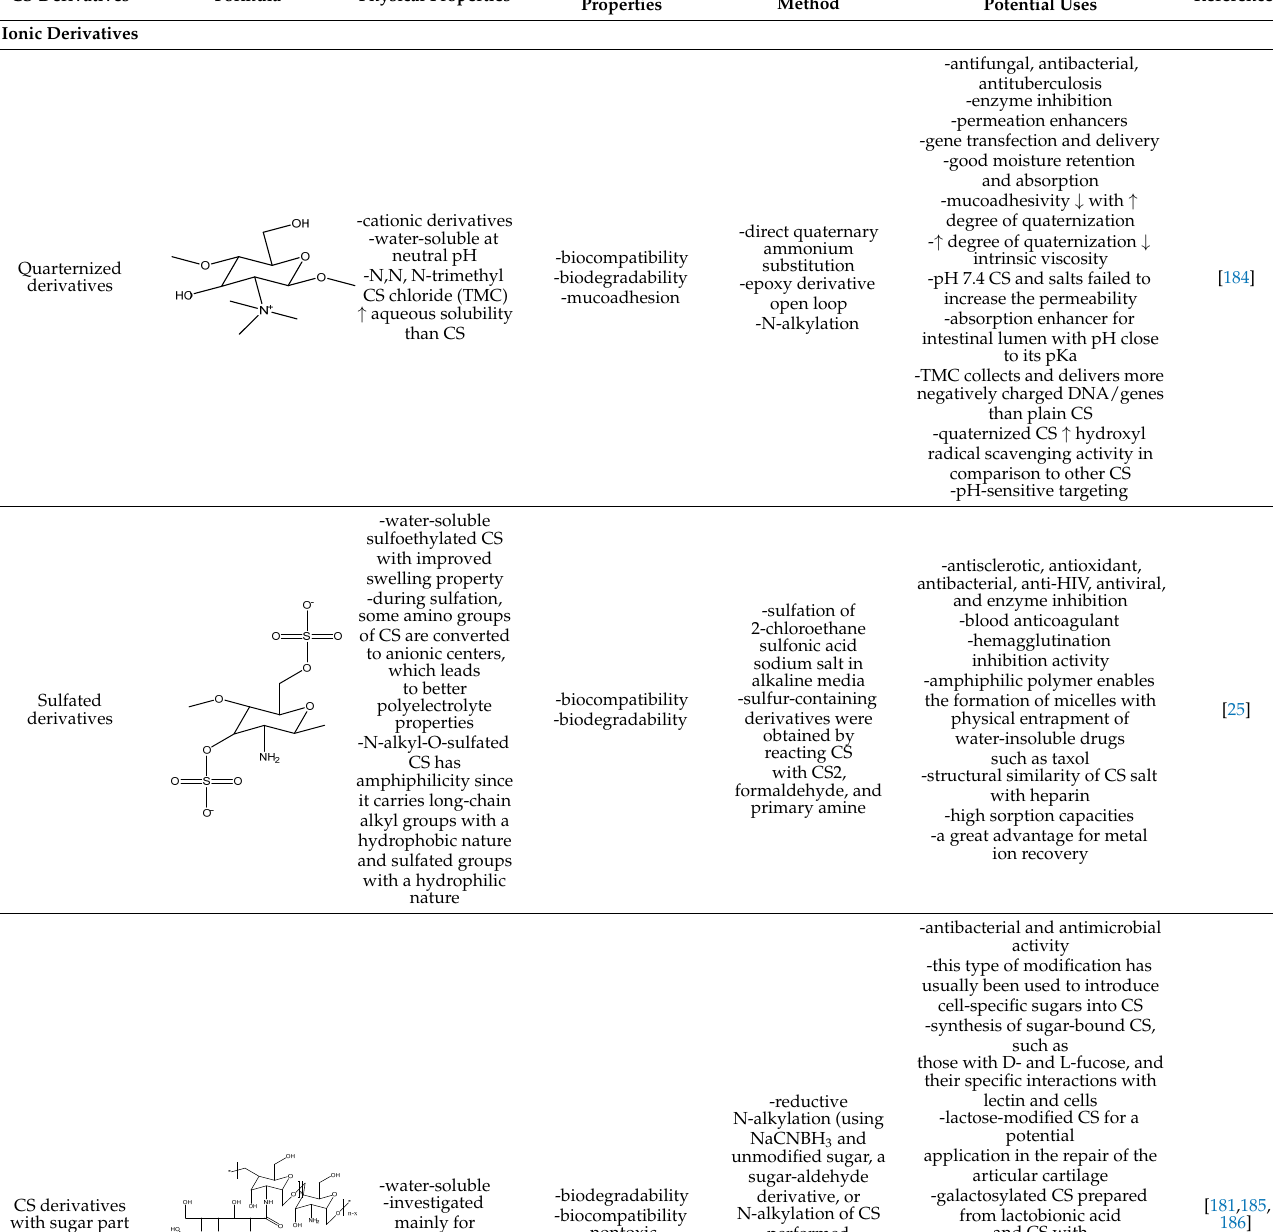
Table 2. CS derivatives applied as antivirals or antiviral carriers, with properties and preparations. CS Deriva-